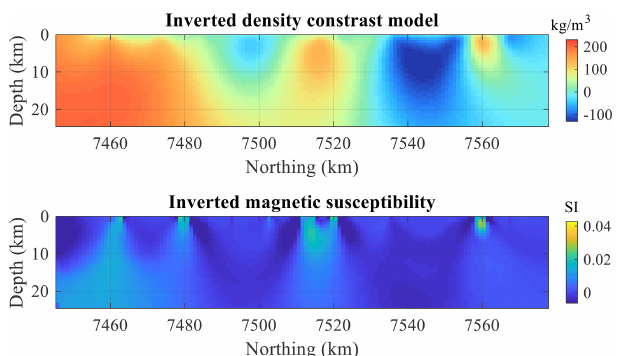
Figure 12. Joint inversion results obtained from utilisation of the cross-gradient